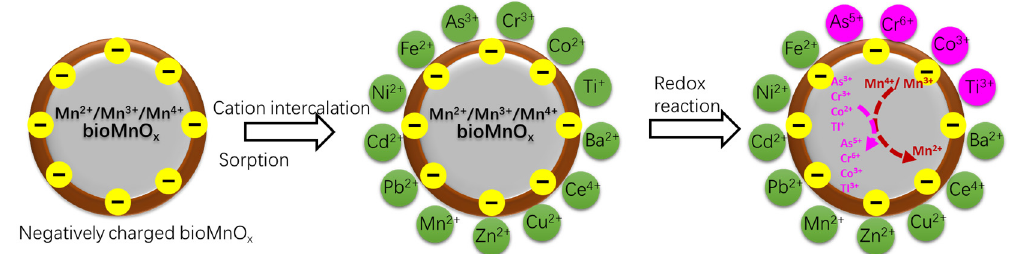
Figure 4. Removal of metals by using bioMnO x .